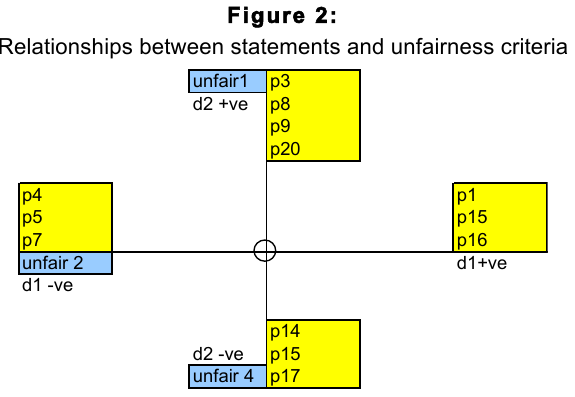
Relationships between statements and unfairness